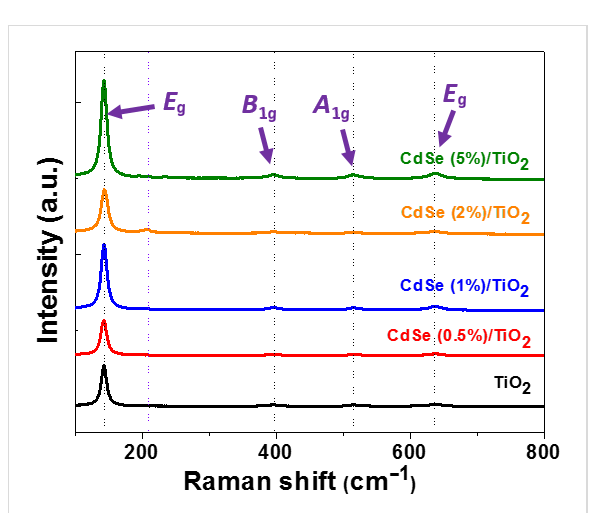
Figure 3: Raman spectra of TiO 2 and CdSe/TiO 2 composites. plotting [ F ( R ) h ν ] 2 vs photon energy and extrapolating the plots at [ F ( R ) h ν ] 2 = 0 ( F ( R ) is the Kubelka–Munk function, h is the Planck constant and ν is the frequency) (Figure 4b). No optical